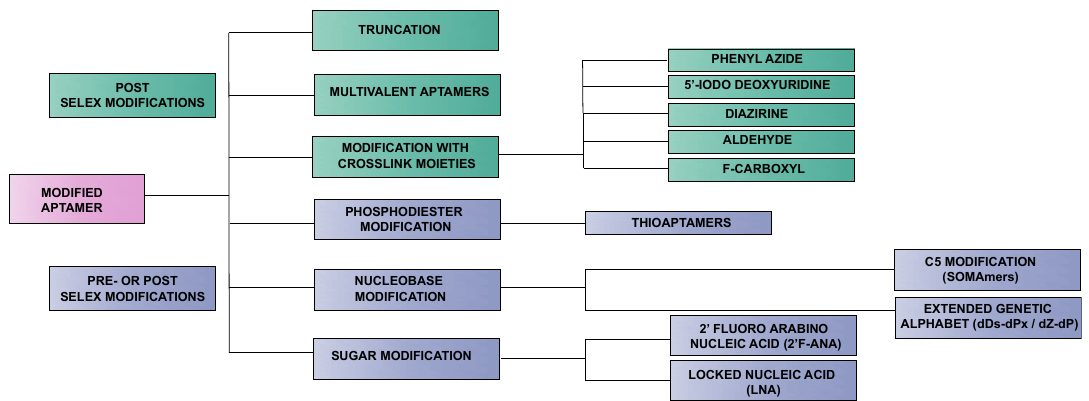
Figure 3. Flow diagram visualizing the aptamer modifications discussed in this review. These modifications are incorporated either via a pre- and/or post-SELEX strategy in the aptamer sequence. The modifications in the green boxes are typical post-SELEX modifications, while the modifications in the purple boxes can be introduced both before (pre) or after (post) the SELEX process.